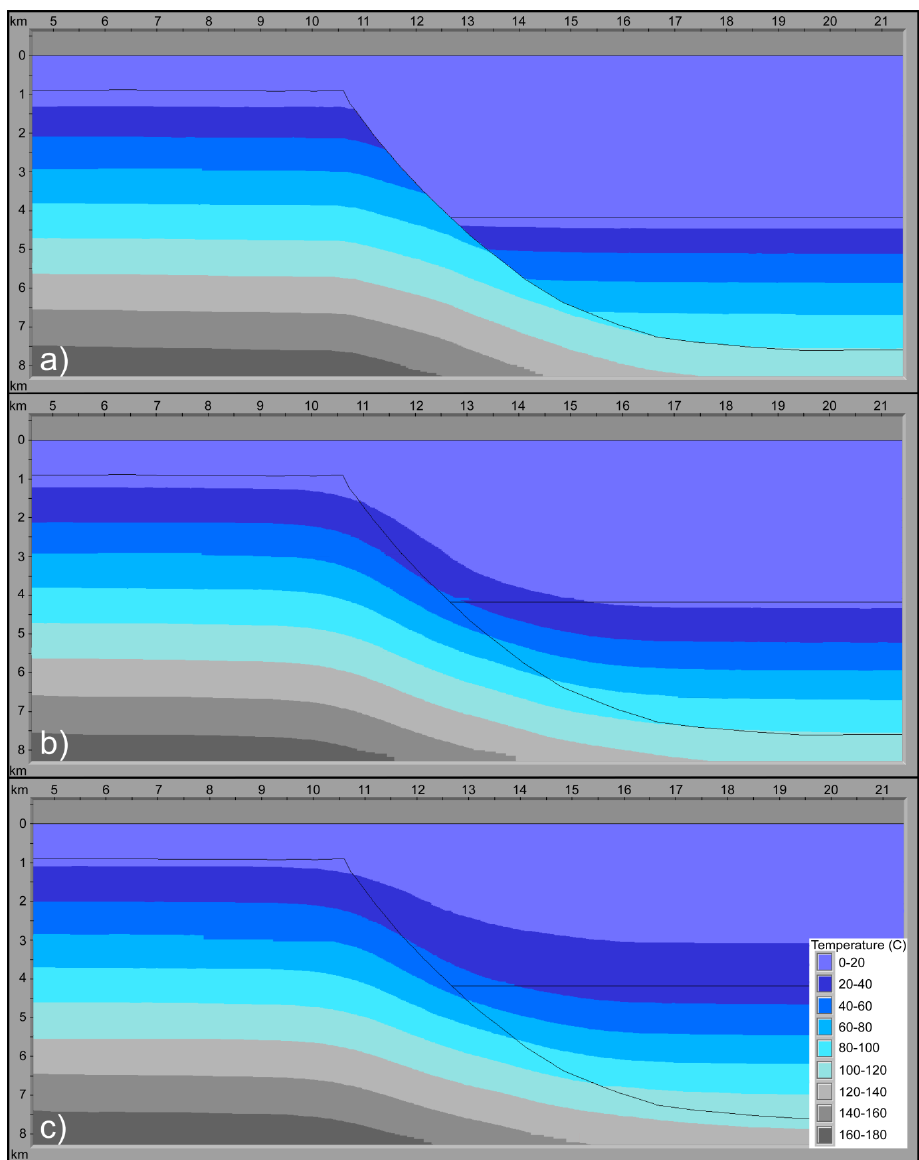
Figure 6. Temperature development in a basin with 3000 m fault slip: temperatures at 1 kyr ( a ), 500 kyr ( b ), and 5 Myr ( c ) after fault slip.